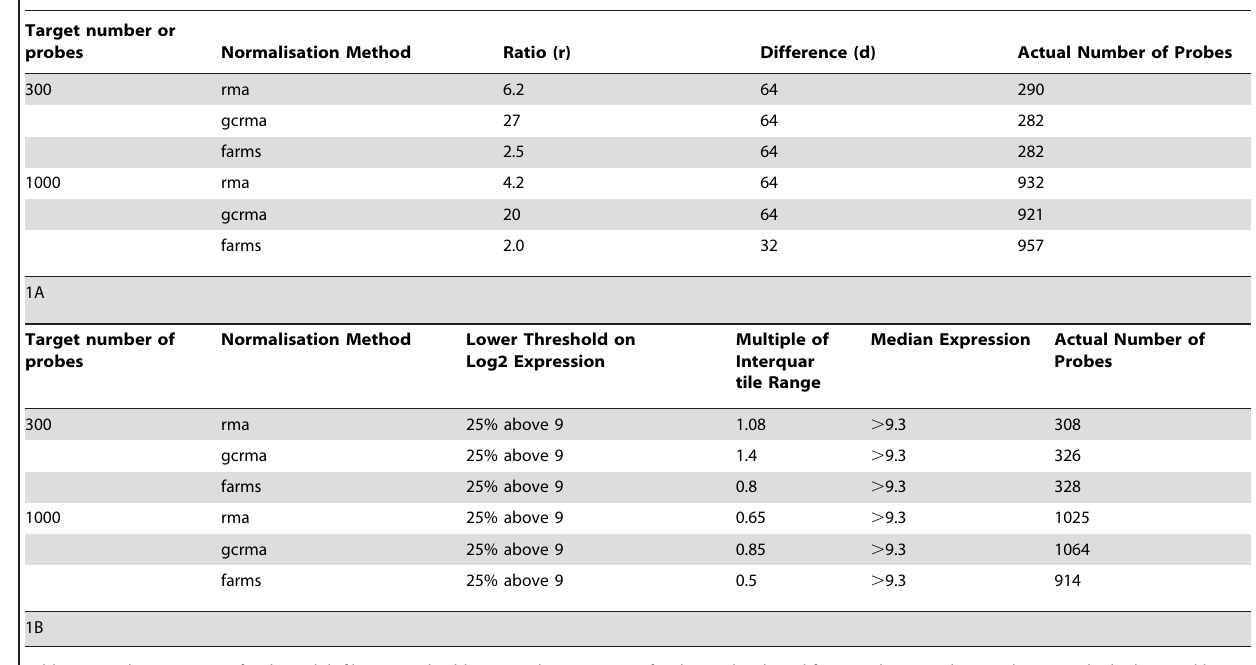
Table 1A are the parameters for the Golub filtering and Table 1B are the parameters for the median based fitting. Where r is the ratio between the highest and lowest level of expression for a particular probe across all the arrays and d is the difference between the maximum and minimum expression levels. IQR is the interquartile range and the lower threshold must be passed by at least 25% of the arrays.